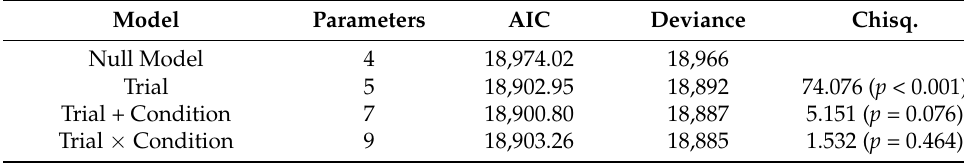
Table 1. Model comparison’s